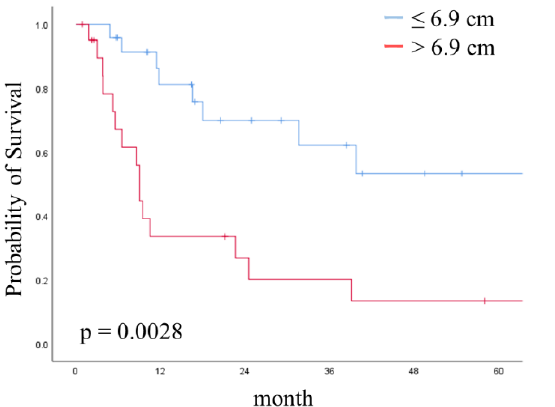
Figure 2. Kaplan–Meier curve showing overall survival (OS) stratified by tumor size in the IVB group. Curves show OS stratified by tumor size at the cut-off of 6.9 cm. p -value was calculated with the log-rank test.